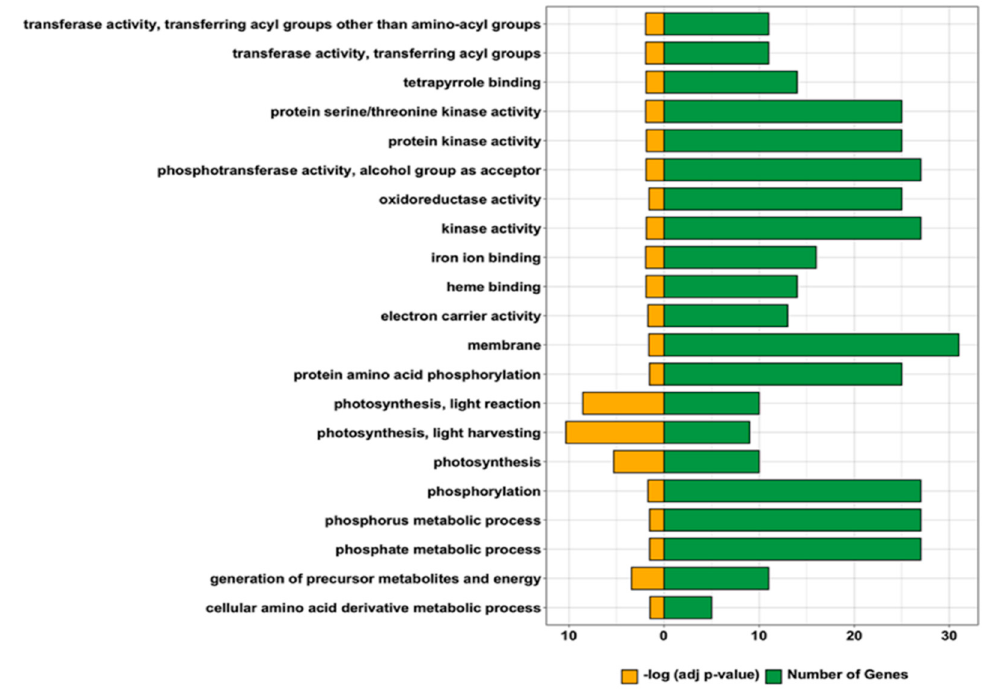
Figure 6. Gene ontology (GO) analysis using agriGO v2.0 reveals enrichment of the differentially expressed genes in W149 compared with Cypress. The significant GO terms are shown on the panel on the left. Yellow bars represent − log (adjusted p -values), whereas green bars show the number of genes for each GO term.